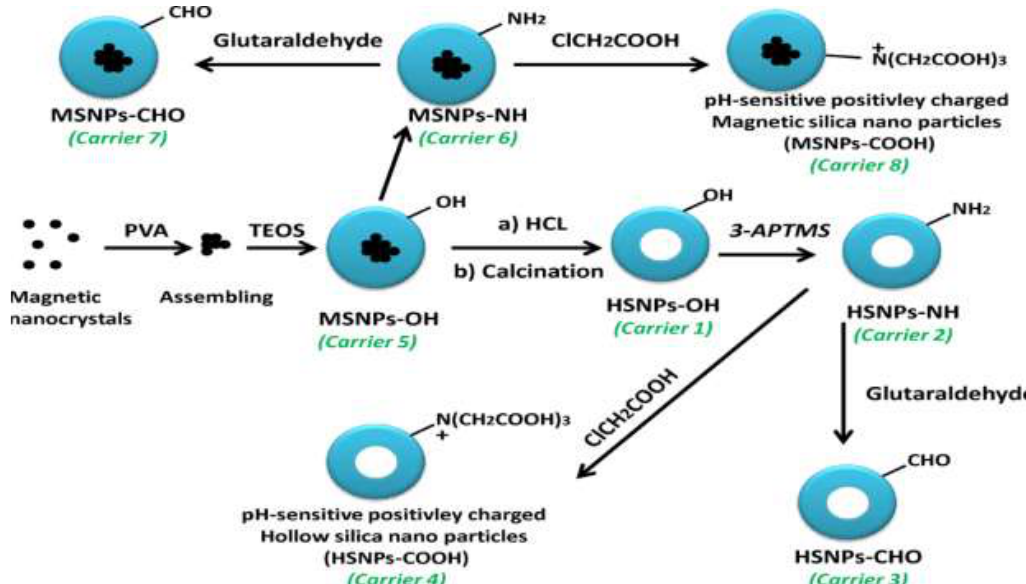
Fig. 1. Illustrations of procedures for preparing porous hollow silica nano